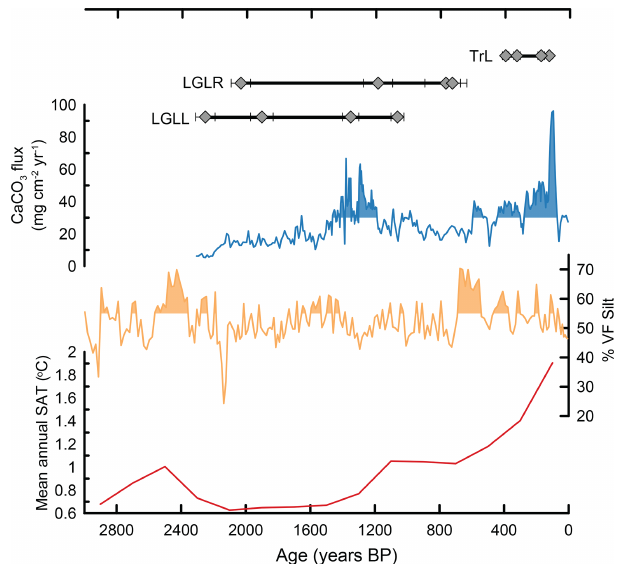
Figure 6. (a) Ages for the late Holocene moraines from this study adjusted to reflect years before present. Black lines indicate the age range for all samples within a moraine population. Gray dia- monds are individual 10 Be ages with 1 σ uncertainty. (b) The blue line shows the CaCO 3 flux from Harrison Lake in Glacier National Park (Munroe et al., 2012). Shaded areas indicate greater than mean values for the time series and are interpreted as increased glacial activity in the original study. (c) The orange line shows the per- cent of very fine silt fraction from Cracker Lake in Glacier National Park (Munroe et al., 2012). Shaded areas indicate greater than mean values and increased glacial activity. (d) The red line is the mean annual surface temperature for our study region taken from Osman et al.